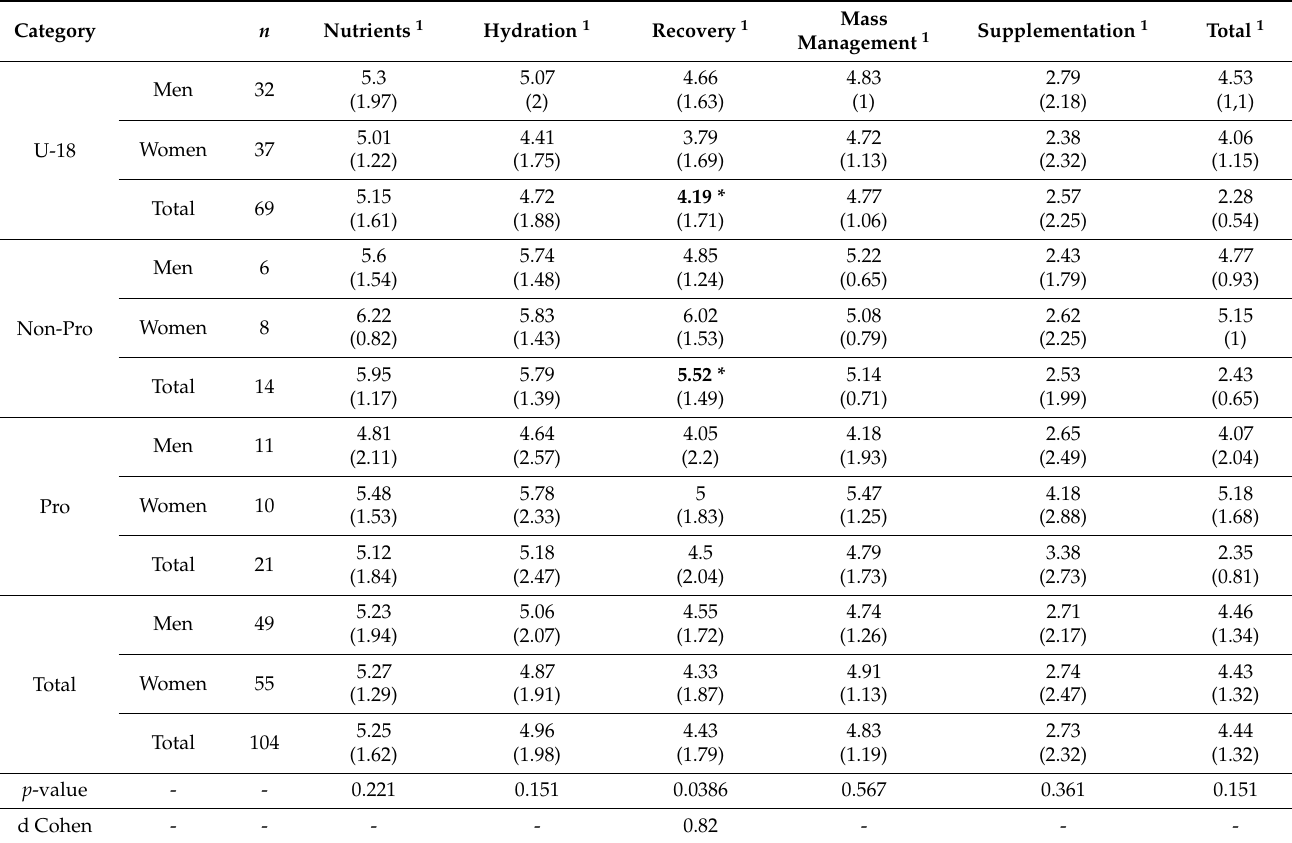
Table 2. Sports nutrition knowledge by category, gender and thematic blocks.